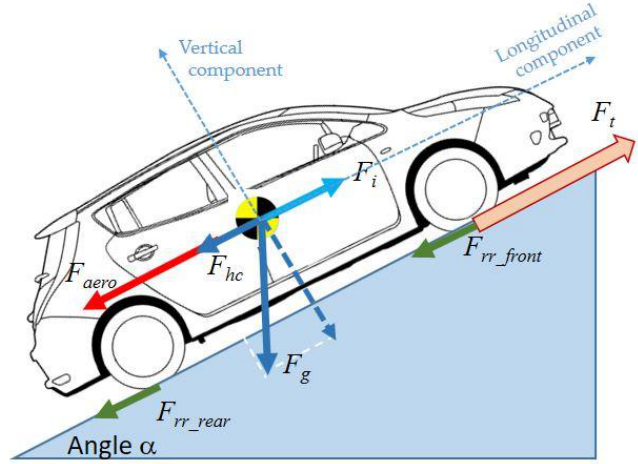
Figure 2. Free body diagram of the different longitudinal forces acting on the vehicle.